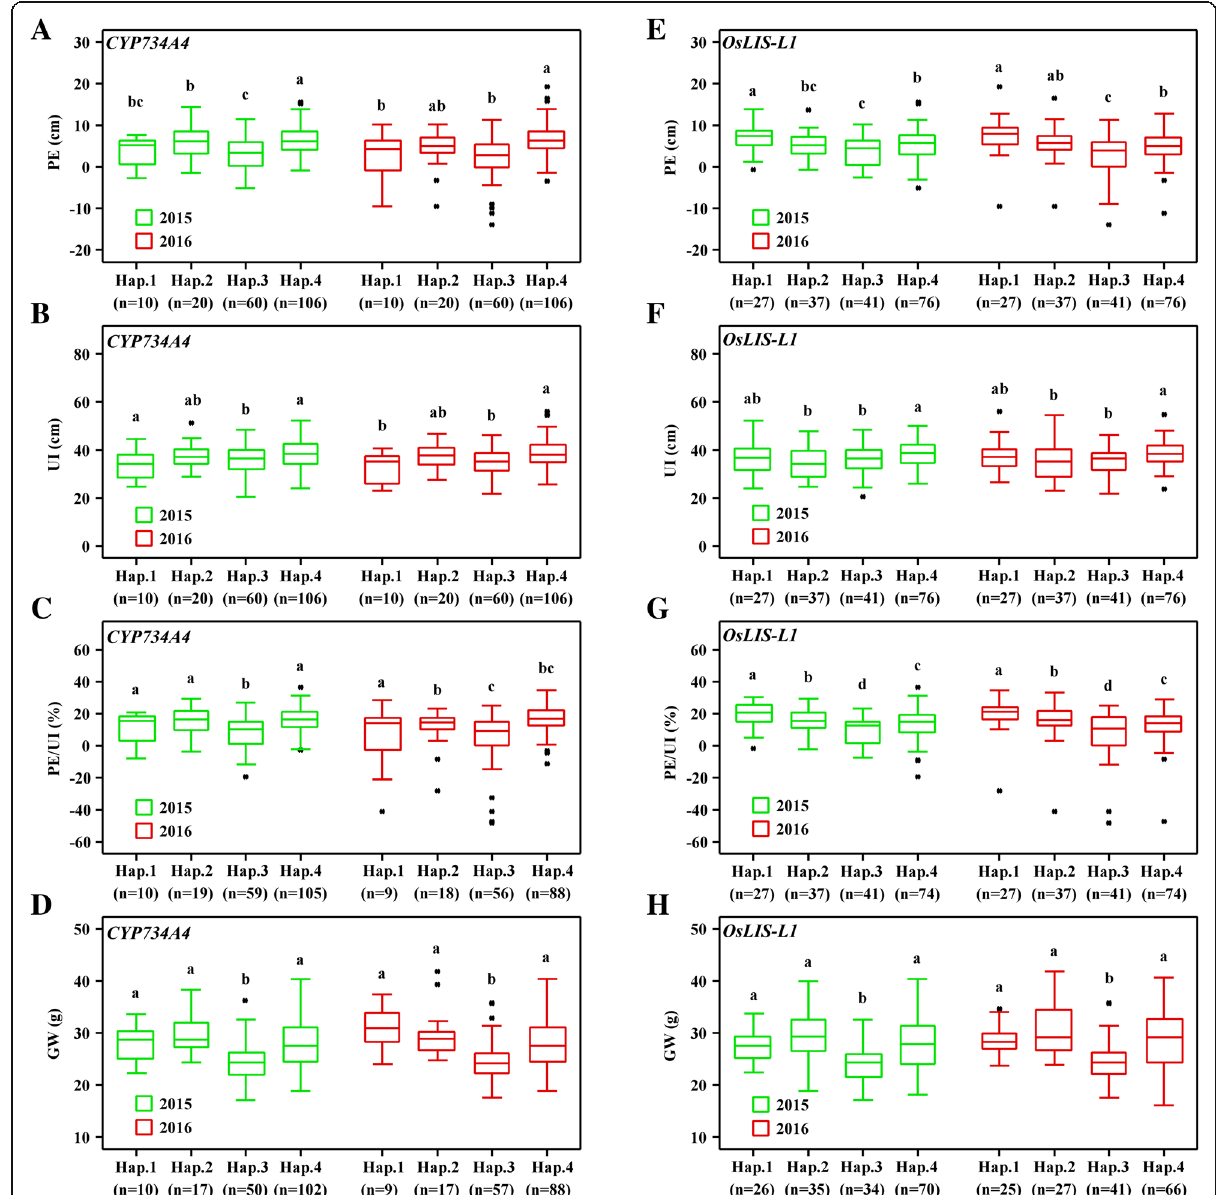
Fig. 7 Box plots of PE, UI, PE/UI, and 1000-GW based on haplotypes of CYP734A4 ( a-d ) and OsLIS-L1 ( e-h ) in 2015 and 2016. n represents the number of accessions with a specific haplotype. The horizontal lines represent the median values, box edges represent upper and lower quantiles, and whiskers are 1.5 times the quantile of the data. Outliers are shown as open dots. Small letters above error bars indicate significant differences among haplotypes (LSD, P < 0.05). CYP734A4 : Hap.1, AA; Hap.2, CN; Hap.3, AT; Hap.4, CA. OsLIS-L1 : Hap.1, CCCAT; Hap.2, CTTAT; Hap.3, TCTGC; Hap.4,